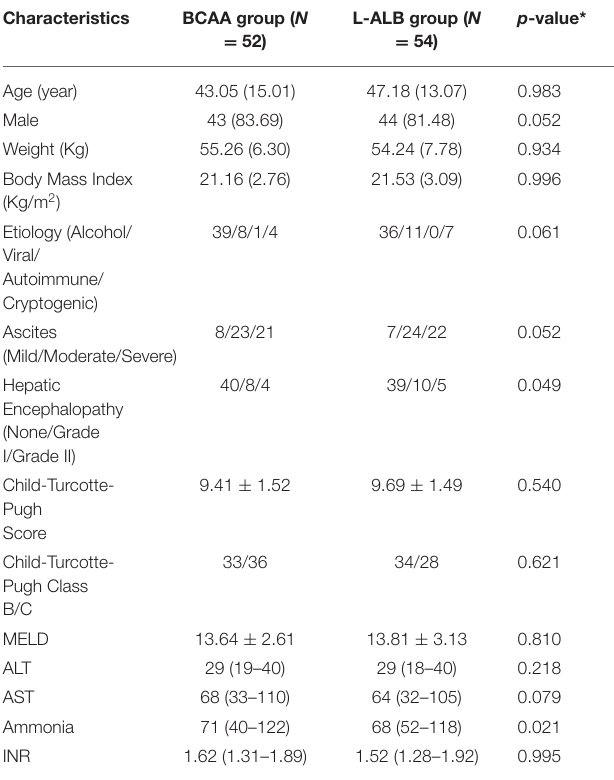
TABLE 1 | Baseline clinical characteristics of 138 patients enrolled in the study. Characteristics